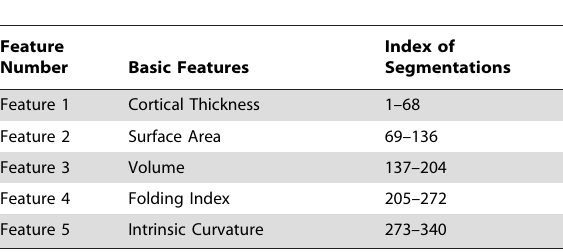
Table 1. Information for the experimental